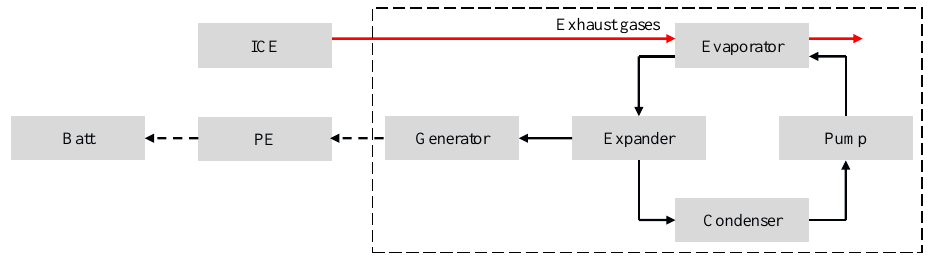
Figure A2. Schematic of an exhaust gas waste heat recovery